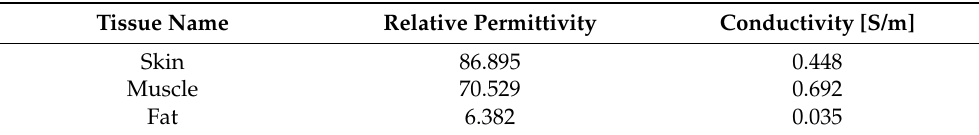
Table 4. Dielectric properties of considered tissues. The dielectric properties are reported at 71 MHz. The values are taken from Gabriel et al.